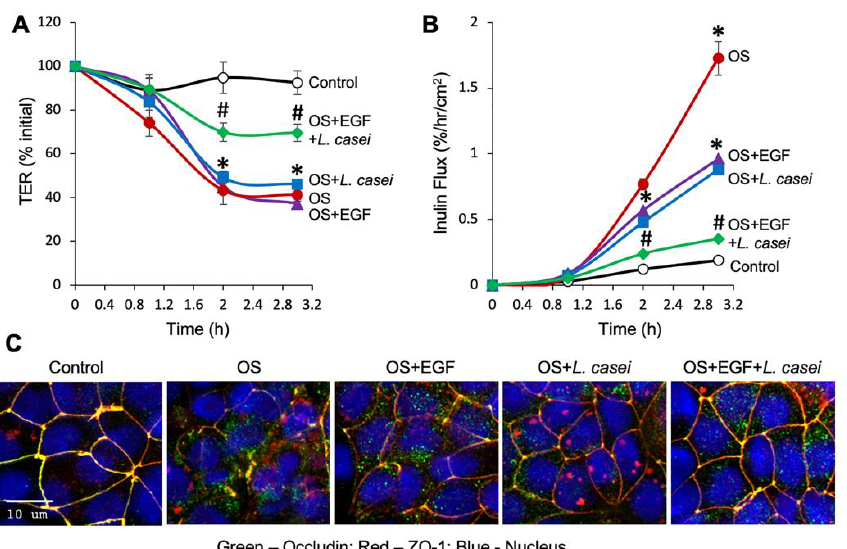
Figure 7. EGF and L. casei synergistically prevents osmotic stress-induced tight junction disruption and barrier dysfunction in Caco-2 cell monolayers. ( A , B ) Caco-2 cell monolayers (11-13 days post-seeding) were pretreated with 10 nM EGF ( ), L. casei (LC; 10 4 cells/mL) ( ■ ), EGF + L. casei ( ⧫ ), or carrier ( ● ) for 30 min followed by osmotic stress (OS) by incubation in hyperosmotic medium. The control monolayers ( ○ ) received no treatments. TER ( A ) and inulin flux ( B ) were measured at varying times. Values are mean ± SEM (n = 6); * indicates the values for OS with or without EGF or LC alone ( ● , ■ , ) are significantly ( p < 0.05) different from the corresponding CTL values ( ○ ); # indicates that OS + EGF+LC values ( ■ ) are significantly ( p < 0.05) different from corresponding OS with or without EGF or LC values ( ● , ■ , ). ( C ) At 3 h of OS treatment, cell monolayers were fixed and co-stained for occludin and ZO-1 and fluorescence images were captured by confocal microscopy. The orange or yellow color in merged images indicate co-localization of occludin and ZO-1.